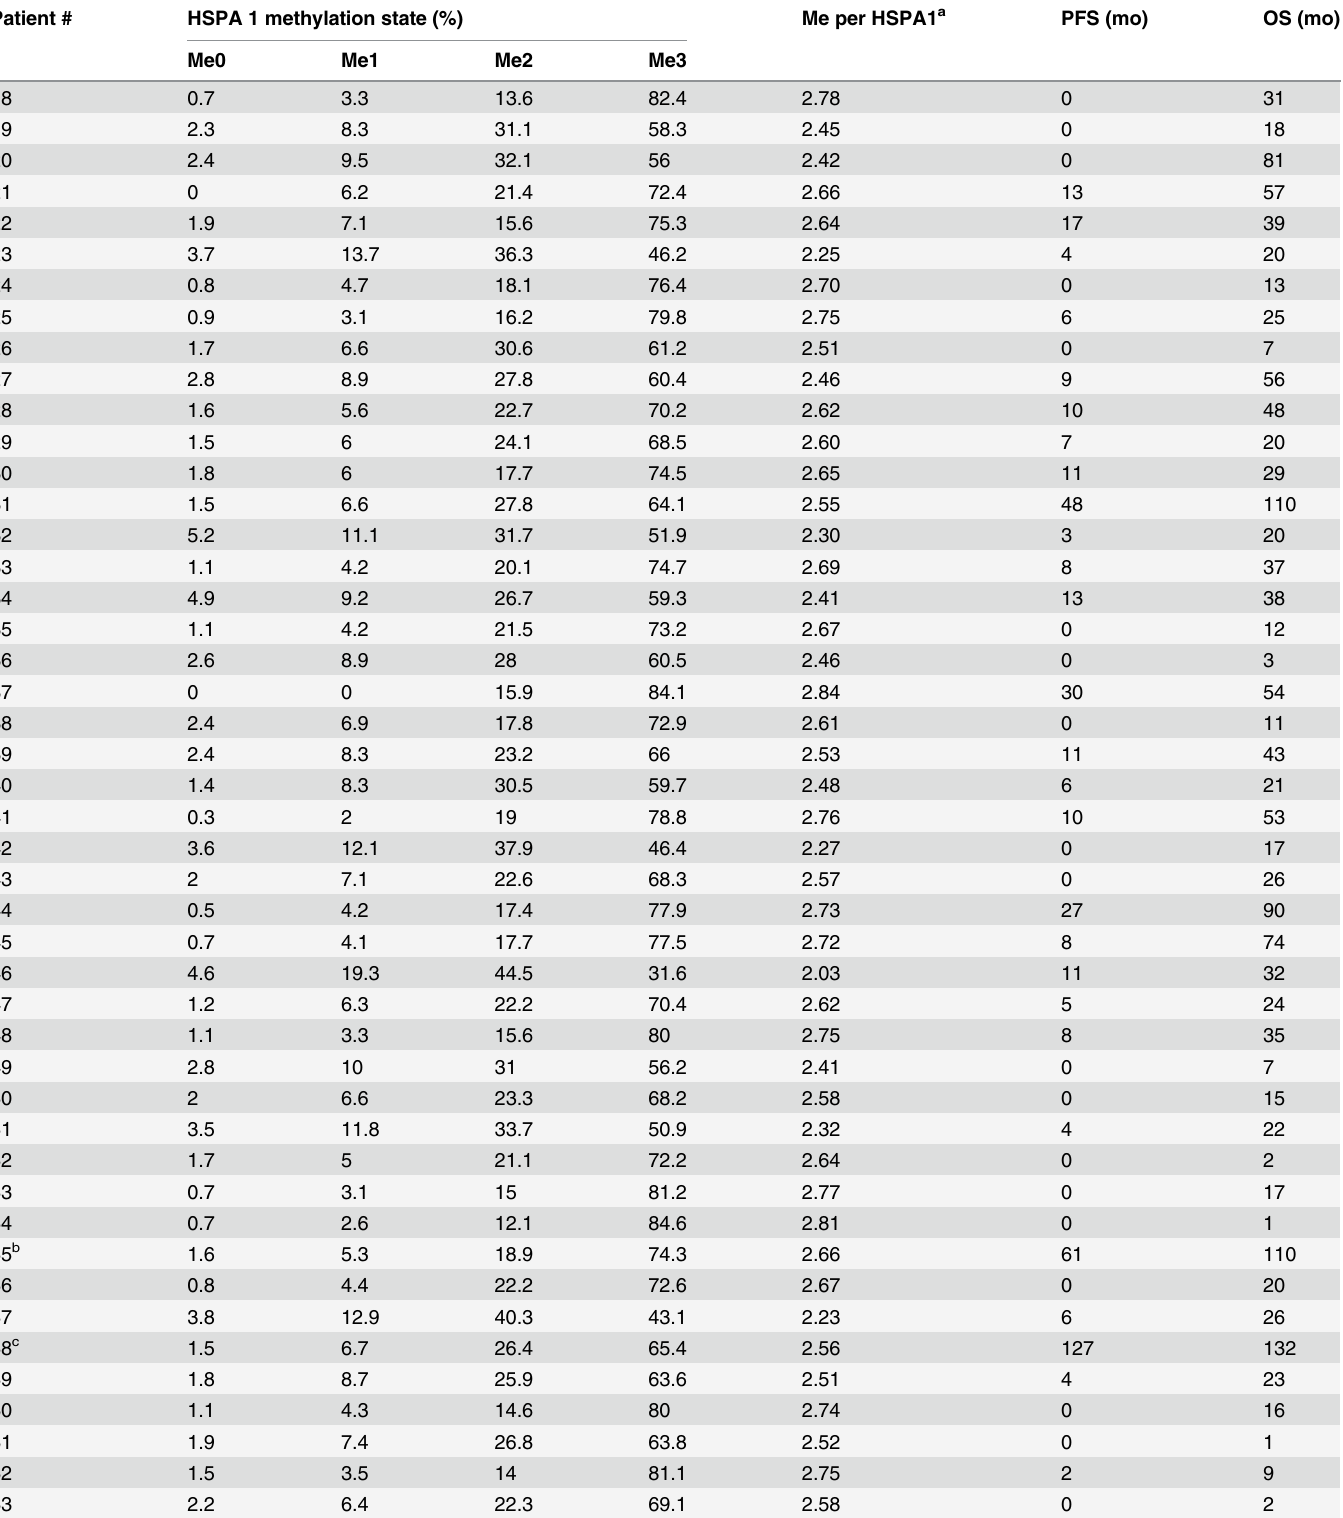
Table 2. HSPA1 methylation and patient survival in